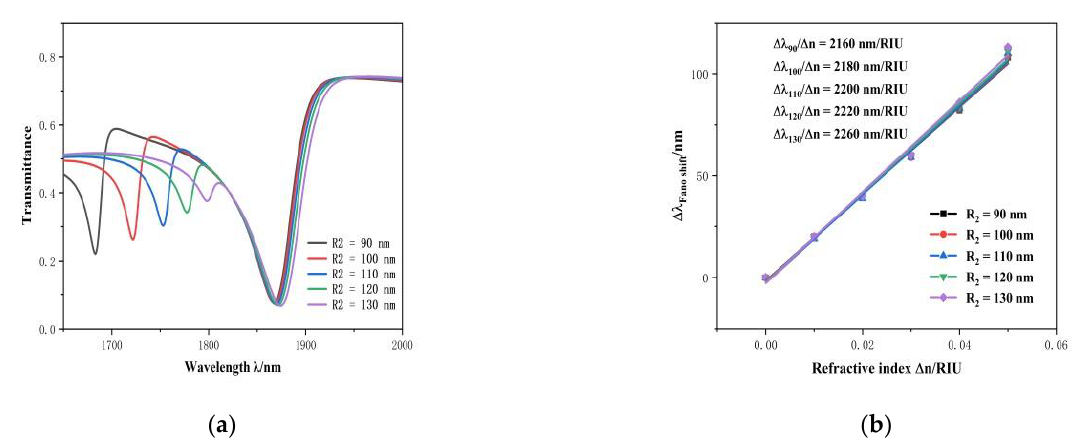
Figure 6. ( a ) Transmission spectra of the inner ring of CCDRR for different external radii R 2 ; ( b ) shifts of the dip point in Fano resonance ( Δλ ) with a changed refractive-index ( Δn ).